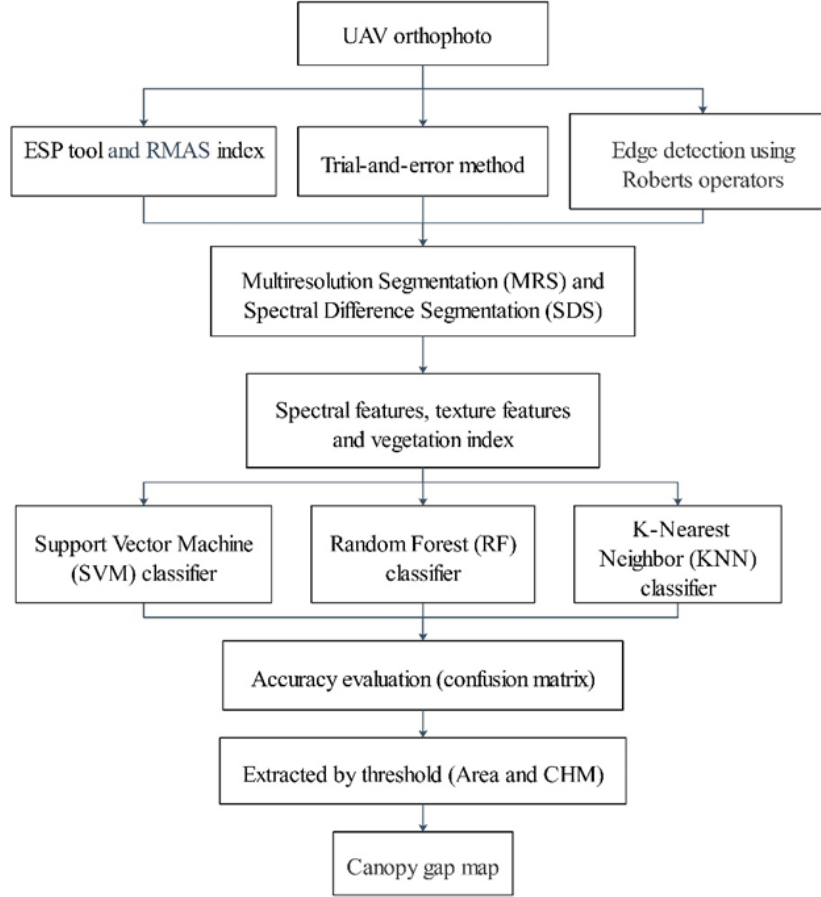
Figure 2. Technical flowchart.